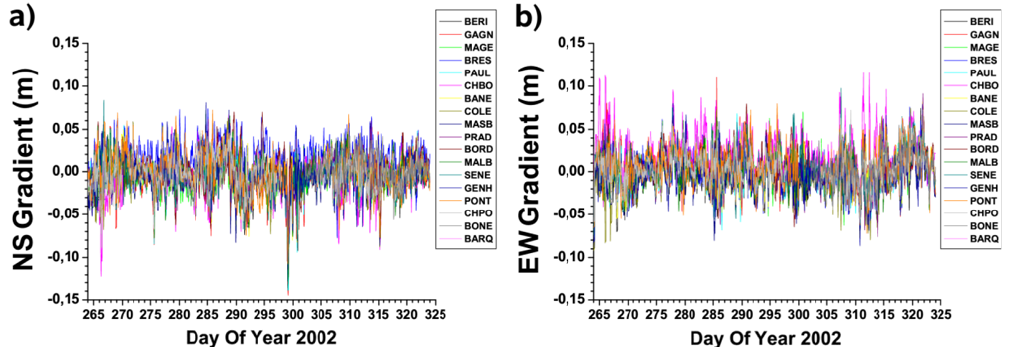
Fig. 11. Time series of horizontal tropospheric gradients for the 18 stations of the local network over the total observation span (doy 264 to 325 of 2002). (a) NS component; (b) EW